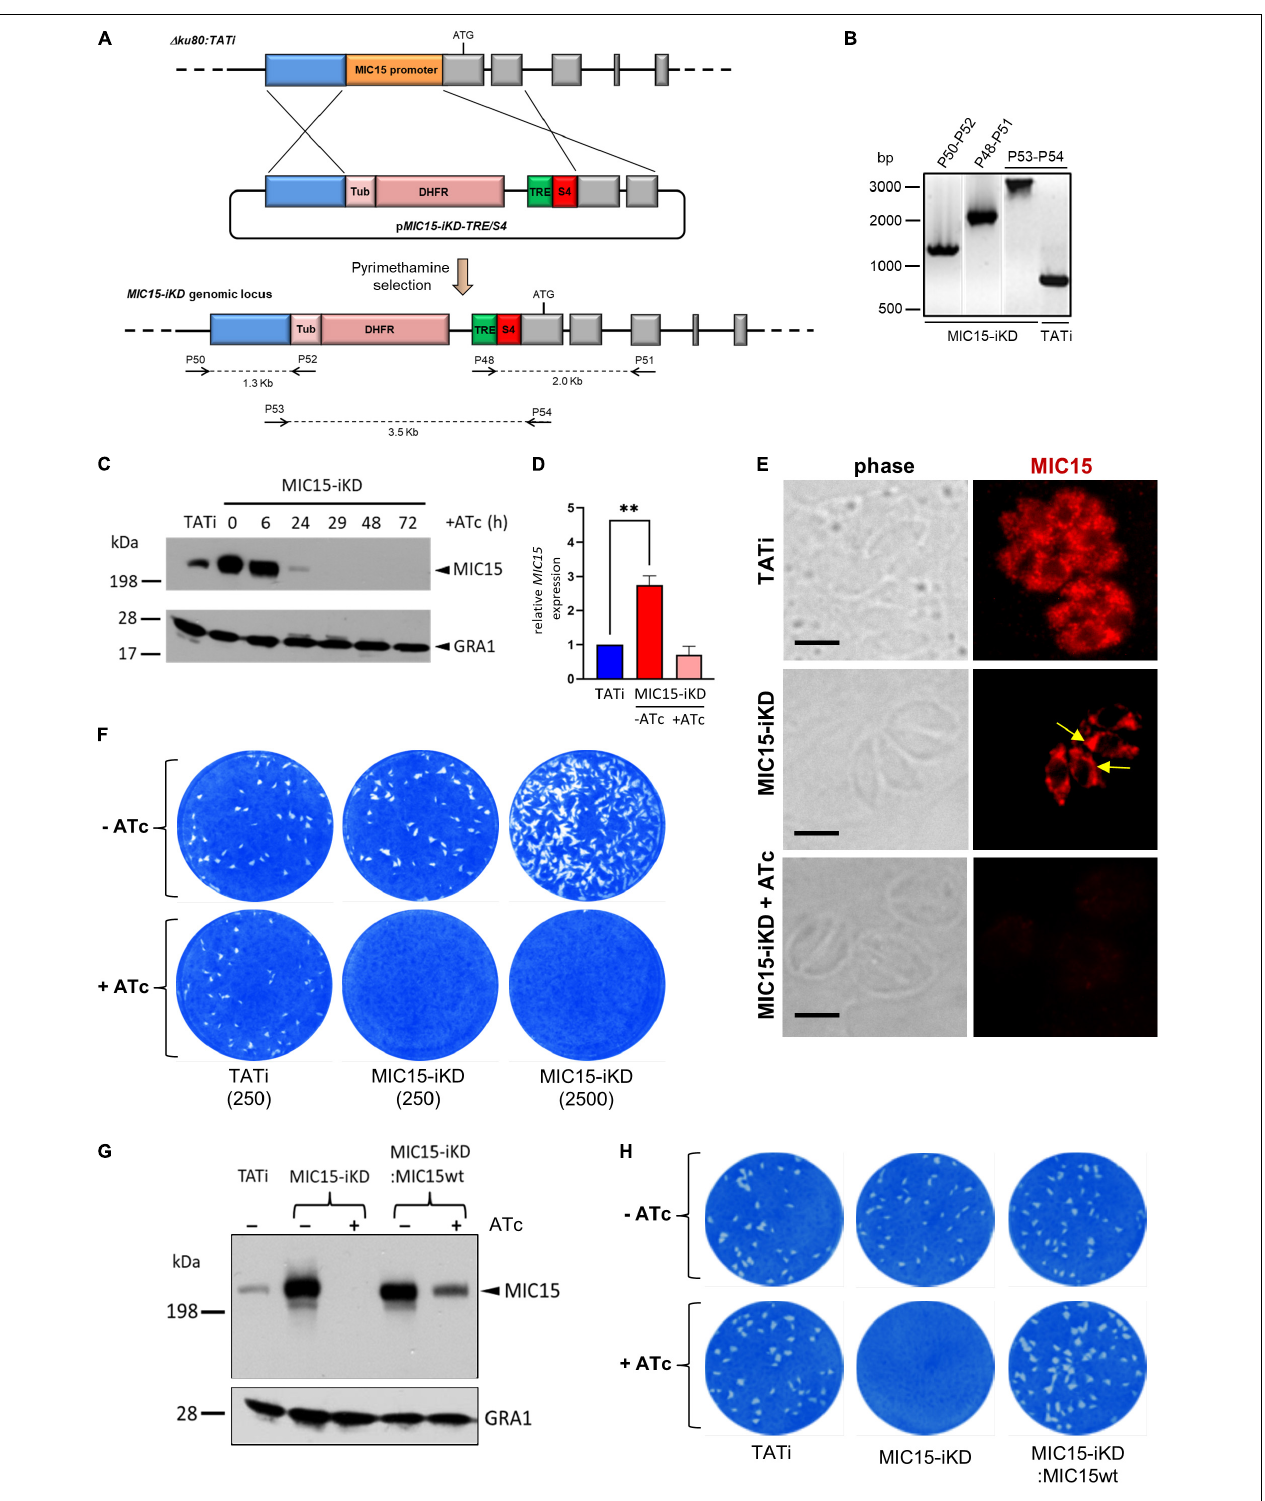
FIGURE 4 | Establishment and validation of a MIC15-iKD conditional-knockdown strain. (A) Double homologous recombination strategy used to replace the MIC15 endogenous promoter with the Tetracycline Responsive Element (TRE) and the SAG4 minimal promoter. The 5 (cid:48) -terminal exons of MIC15 are represented as gray boxes. The arrows represent the primers used for diagnostic genomic PCR amplifications. (B) PCR analysis of the MIC15-iKD strain confirming the correct genomic integration of the DHFR/TRE-SAG4 cassette. (C) Time course Western blot analysis of MIC15-iKD tachyzoites treated with 0.5 µ g/ml Atc for 6–72 h